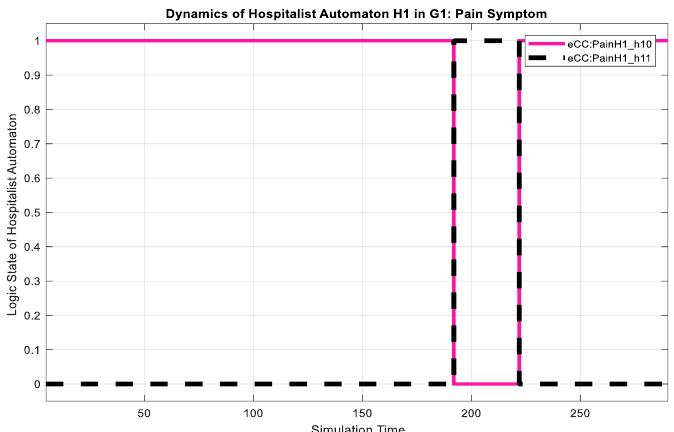
Figure 19. Dynamics of the nursing station, 𝑵 𝟏 , in terms of monitoring the pain symptom.